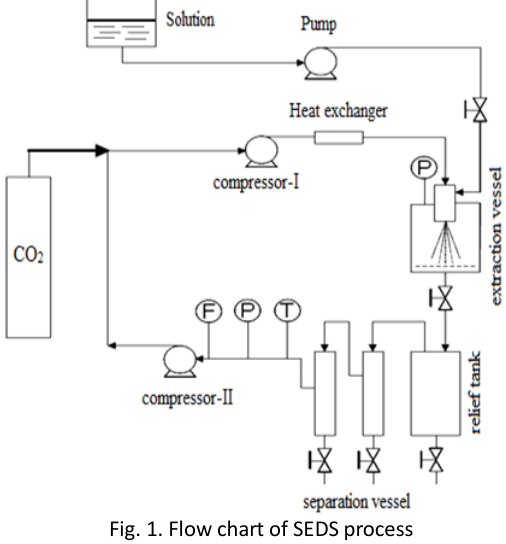
Fig. 1. Flow chart of SEDS process